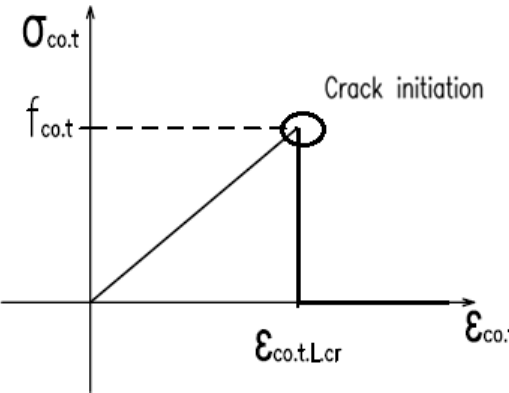
Figure 3. Stress–strain diagram for concrete under tension.